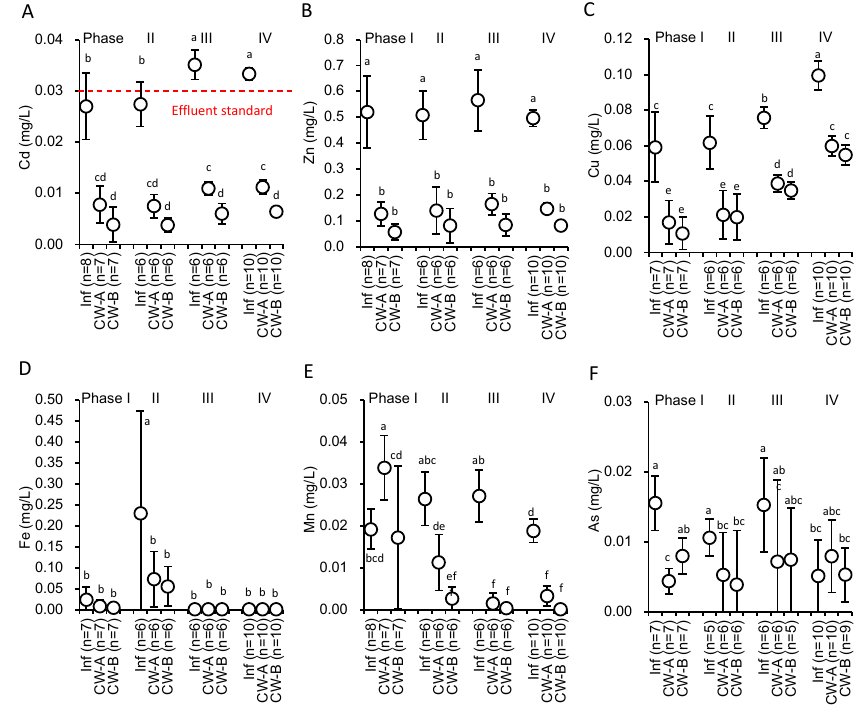
Figure 4. Summary of influent and effluent metal concentrations in phases I (HRT 3.8 days), II (2.4 days), III (1.7 days), and IV (1.2 days) in the unplanted CW (CW-A) and the cattail-planted CW (CW-B) treating NMD. Cd ( A ), Zn ( B ), Cu ( C ), Fe ( D ), Mn ( E ), and As ( F